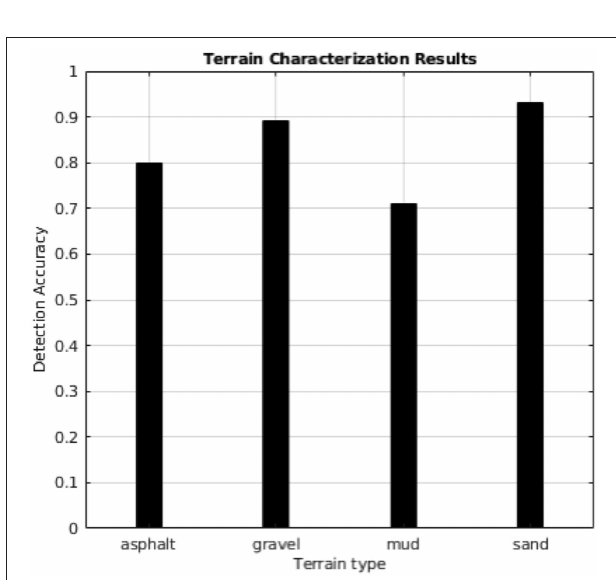
FIGURE 14 | The accuracy of the proposed classification